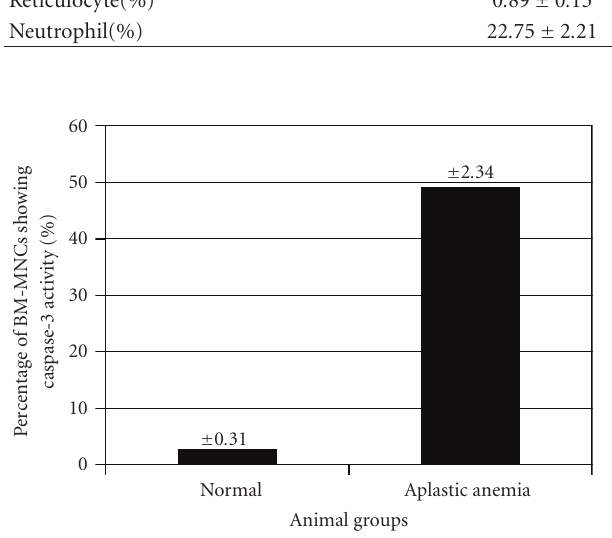
Figure 3: Caspase-3 activity showed by BM-HSCs in Aplastic anemia (49% ± 2.34%) ( P < . 05) was significantly higher compared to that of the normal counterpart (2.6% ± 0.31%) ( P < . 01).